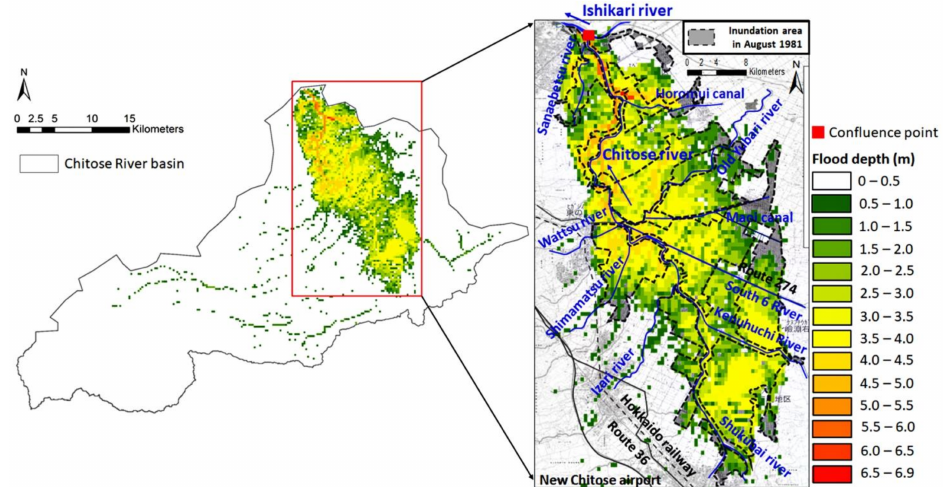
Figure 5. Comparison between the simulated and observed inundation areas for the flood event of August 1981 in the